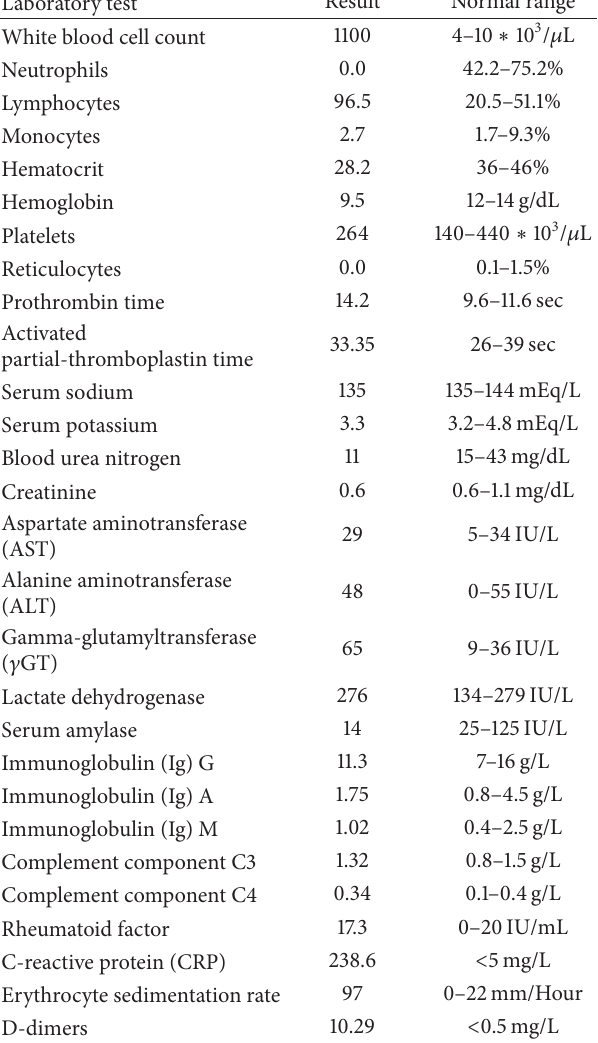
Table 1: Main investigations of the patient performed during hospi- talization.